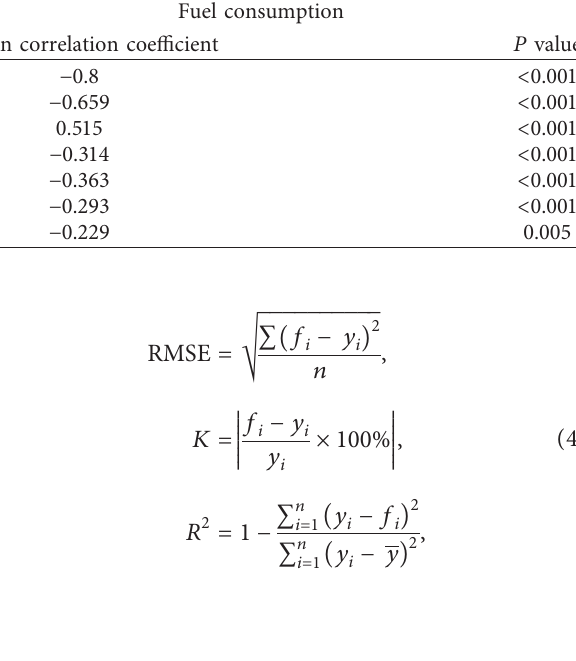
Table 4: Correlation analysis of driving behavior collected from mobile phone termination and fuel consumption collected from OBD. Average speed V mean